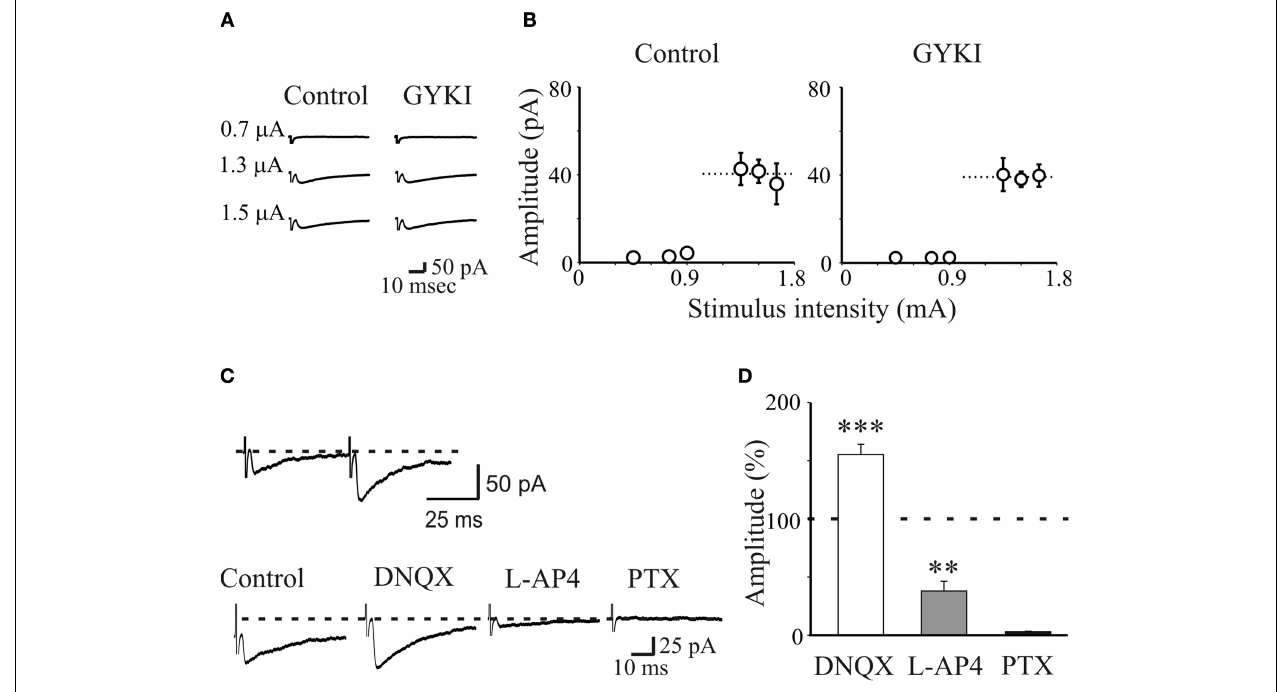
FIGURE 1 | AMPA receptors do not contribute to unitary postsynaptic currents evoked in CA3 principal cells by minimal stimulation of granule cells in the dentate gyrus. (A) Unitary synaptic currents evoked in a CA3 pyramidal cell at P4 with different stimulation intensities before (Control) and during application of GYKI 52466 (30 µM). Each trace is the average of 15–20 responses (including failures). (B) Peak amplitudes of synaptic currents represented in (A) are plotted as a function of stimulus intensities. Bars are